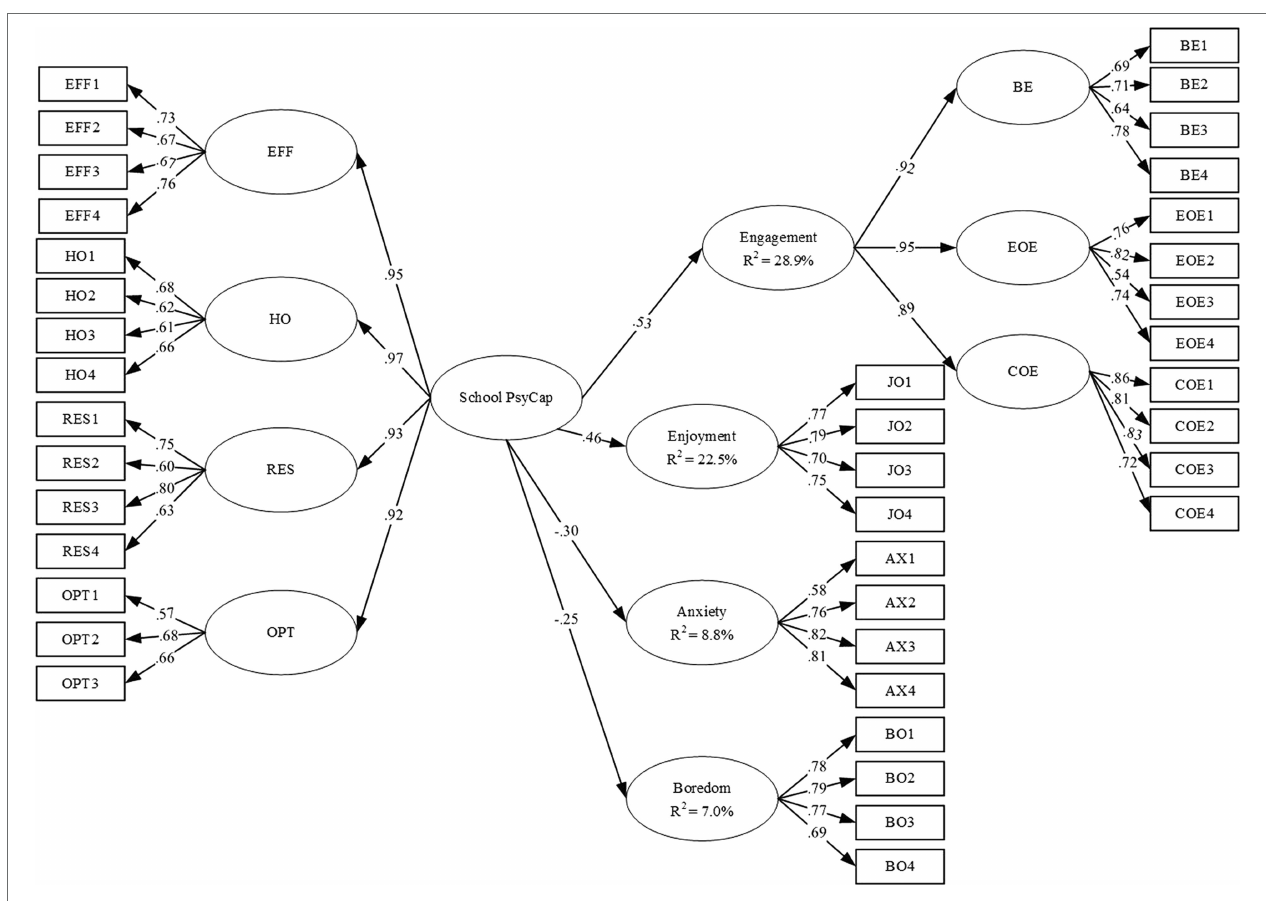
FIGURE 1 | Final structural equation model on school PsyCap and academic outcomes. EFF, self-efficacy; HO, hope; RES, resilience; OPT, optimism; BE, behavioral engagement; EOE, emotional engagement; COE, cognitive engagement. All parameters in the figure are standardized coefficient and all paths are significant at p < 0.001. For brevity reason, the residuals are not presented in the figure. Gender and age are the